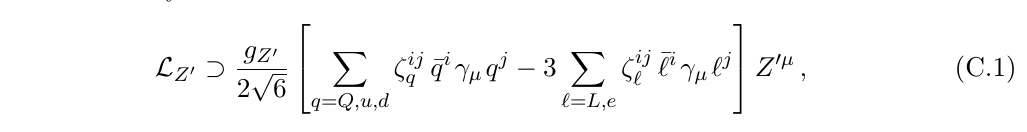
= 1 and M Z 0 = 2 TeV . Further details Z can be found in the main ψ